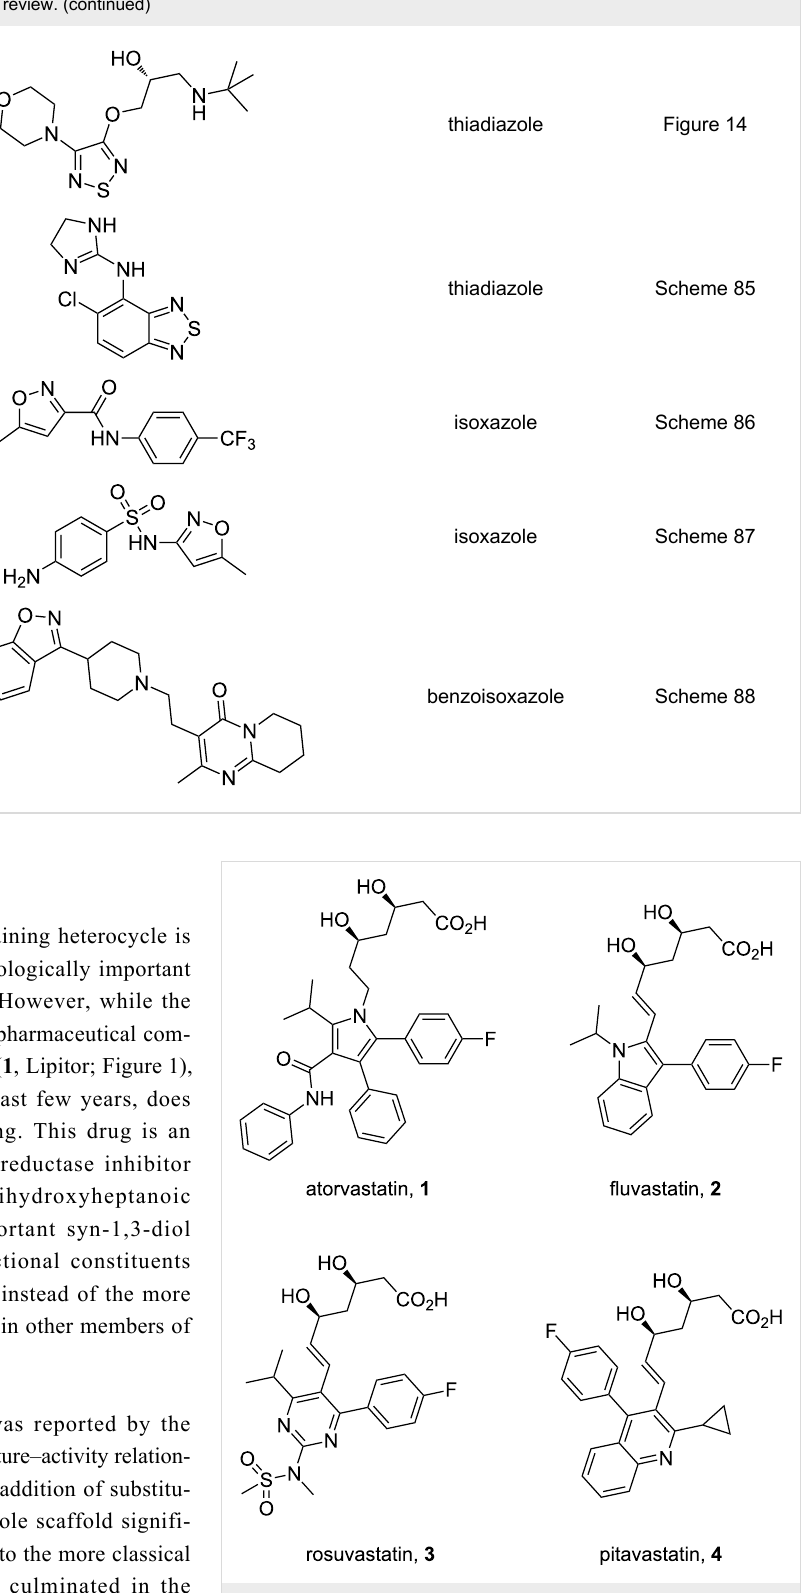
Figure 1: Structures of atorvastatin and other commercial